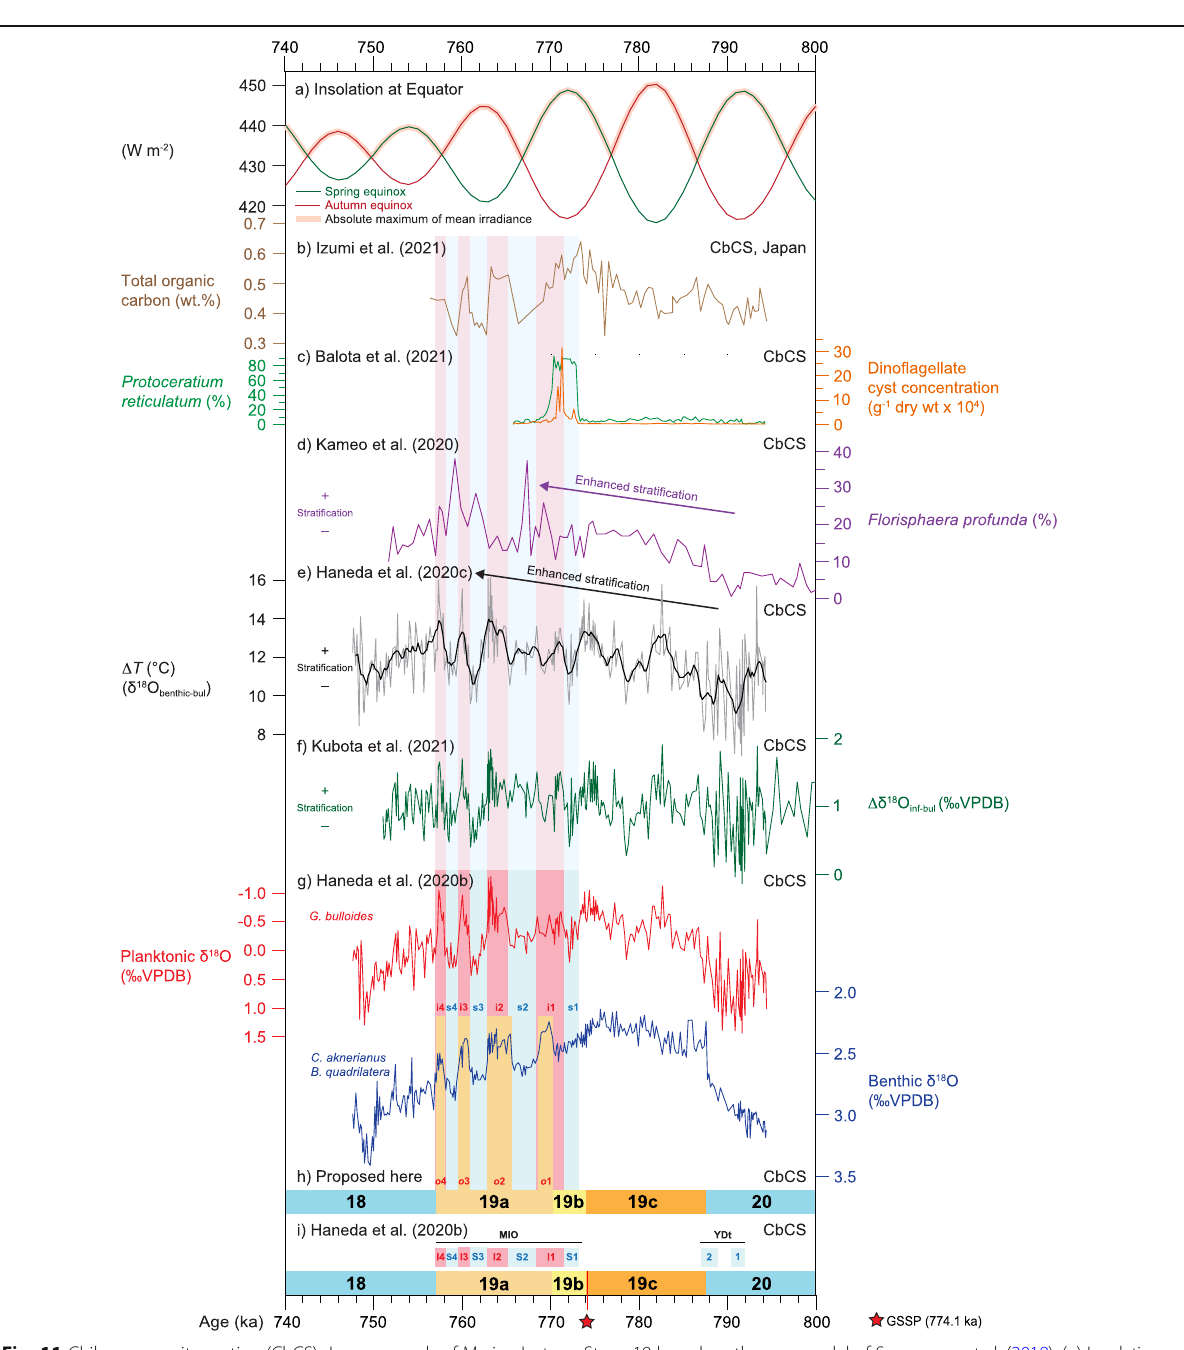
Fig. 11 Chiba composite section (CbCS), Japan; records of Marine Isotope Stage 19 based on the age model of Suganuma et al. (2018). ( a ) Insolation at Equator in spring and autumn, and absolute maximum of mean irradiance (Laskar et al. 2004; Ferretti et al. 2015; Haneda et al. 2020b). ( b ) Total organic carbon wt.% (Izumi et al. 2021). ( c ) Percentage abundance of Protoceratium reticulatum cysts and total dinoflagellate cyst concentrations interpreted as a southward shift of the Kuroshio Extension during stadial s1 and early interstadial i1 (Balota et al. 2021). ( d ) Percentage abundance of calcareous nannofossil Florisphaera profunda , an indicator of near-surface ocean stratification (Kameo et al. 2020). ( e ) Profile of Δ T ( δ 18 O benthic minus δ 18 O Globigerina bulloides ) as a measure of the vertical temperature gradient between surface and bottom waters (thin grey line) and 1000-year moving average (thicker black line) (Haneda et al. 2020b, 2020c). ( f ) Profile of Δδ 18 O inf-bul ( δ 18 O Globorotalia inflata minus δ 18 O Globigerina bulloides ) as an indicator of near-surface ocean stratification (Kubota et al. 2021). ( g ) Planktonic and benthic foraminiferal δ 18 O records (Haneda et al. 2020b). ( h ) The MIS 19 subdivisional scheme used here (Fig. 7): benthic marine isotope oscillations o 1 – o 4 and interstadials i1 – i4 are labelled in red, stadials s1 – s4 are labelled in blue. ( i ) Substage classification and interstadial and stadial classification and labelling of Haneda et al. (2020b) where MIO = Millennial Isotopic Oscillation, showing MIO-Stadial 1 to 4 (MIO-S1 to MIO-S4), and MIO-Interstadial 1 to 4 (MIO-I1 to MIO-I4); YDt = Younger Dryas-type cooling